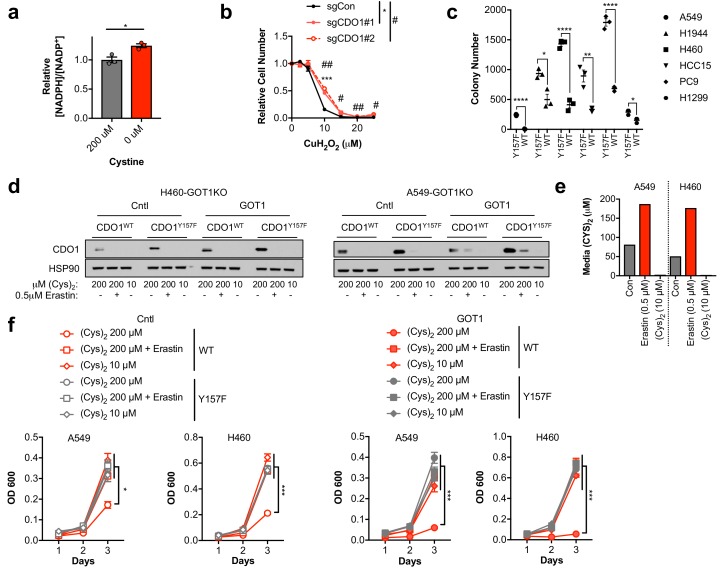
Cystine uptake and reduction depletes NADPH.(a) The NADPH/NADP+ ratio was assayed following growth of A549 cells in medium containing 200 µM or 0 µM cystine for 24 hr. The ratio was normalized to cells grown in 200 µM cystine. N = 3 replicates/group. (b) H1581 cells were infected with lentivirus encoding Cas9 and non-targeting (sgCON) or CDO1-targeting (#1, #2) sgRNAs to delete CDO1 in the bulk population. Cells were treated with the indicated doses of CuH2O2 for 24 hr and cell number normalized to EtOH (Vehicle) treated cells. N = 3 replicates/group. (c) Soft agar growth of NSCLC cell lines expressing CDO1Y157F (Y157F) or CDO1WT (WT). Cells were treated with 0.25 µg/ml doxycycline for 2 days prior to and during the assay. N = 3 replicates/group. (d) Western blot analysis of CDO1 and HSP90 levels in GOT1 KO A549 and H460 cells expressing empty pMXS (Cntl) or reconstituted with pMXS-GOT1 (GOT1), followed by expression of CDO1Y157F or CDO1WT. Cells were cultured in either 200 µM or 10 µM (Cys)2, or 200 µM (Cys)2 + 0.5µM Erastin. (e) Quantification of medium (Cys)2 levels following Erastin treatment or growth in 10 µM (Cys)2. Control medium contains 200 µM (Cys)2. (f) Analysis of the proliferation of the cells from (d). Cells were fed with fresh media daily, collected on the indicated days, stained with crystal violet and their absorbance at 600 nm determined. N = 3 replicates/group. For (d,f), cells were treated with 0.25 µg/ml doxycycline for 2 days prior to and during the assay, and fresh medium was added 5 hr prior to sample collection (d) or during the assay (f).10.7554/eLife.45572.036Figure 7—figure supplement 1—source data 1.Cystine uptake and reduction depletes NADPH.